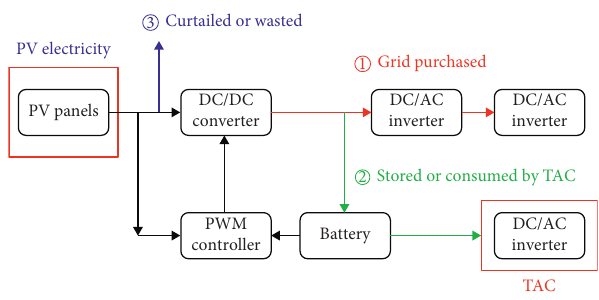
Figure 8: Flowchart of three ways to use PV electricity. Table 11: The results of the LCC when considering a curtailment rate of